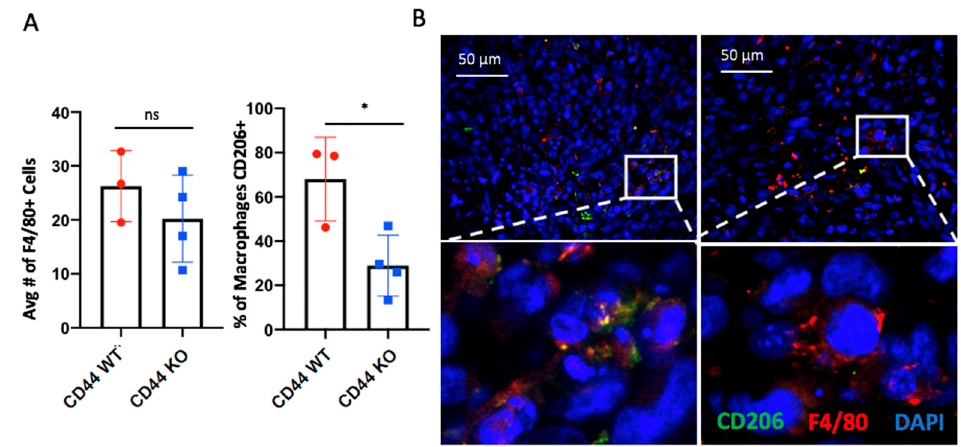
Figure 6. CD44 deletion in Hs578T tumors decreases the number of infiltrating CD206 + macrophages. ( A,B ) Histological analysis of early tumors using immunofluorescence to identify CD206 in green, F4 / 80 in red, and nuclei in blue (using DAPI). ( A ) The total number of F4 / 80 + cells and percent CD206 + was quantified using five representative images from each tumor (CD44 WT n = 3, CD44 KO n = 4). Images were acquired on a Leica DM400B microscope at 400 × magnification. Statistical analysis was performed using Student’s unpaired, two-tailed t -test. Error bars represent standard error of the mean. P values * p < 0.05, ns = not significant .